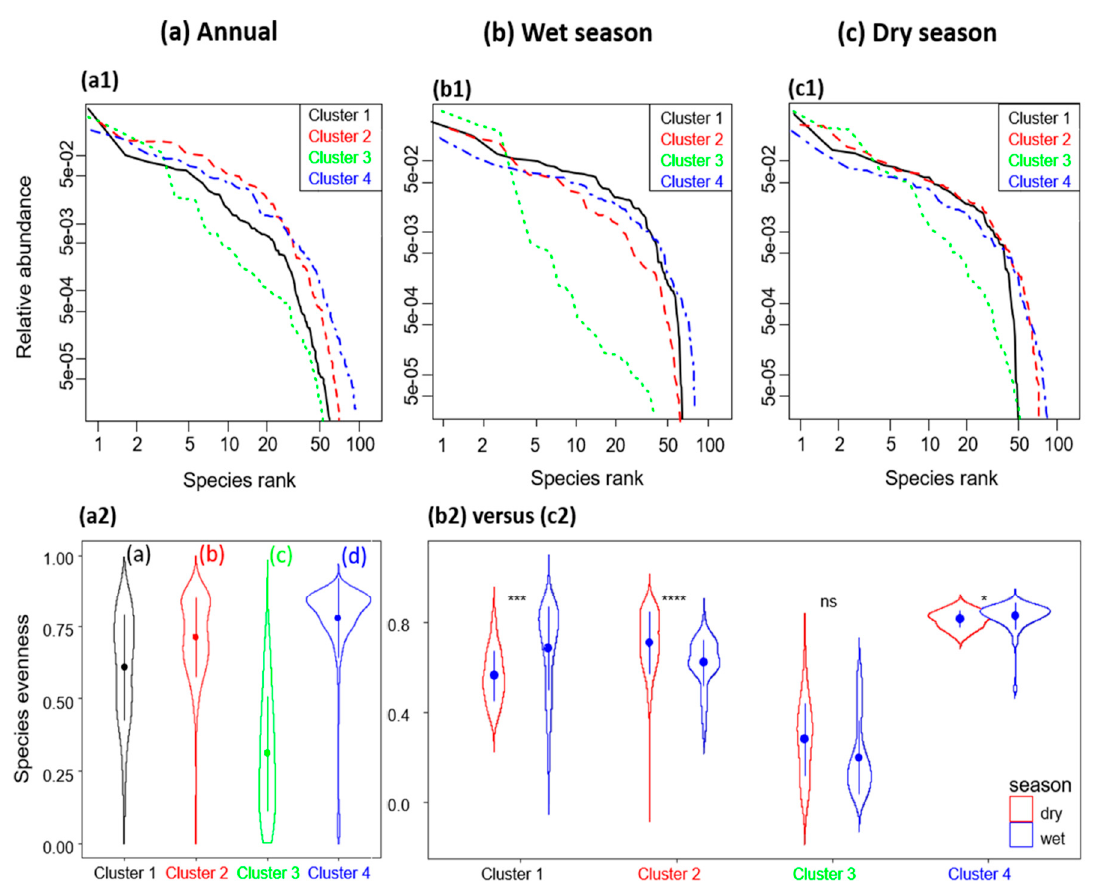
Figure 4. Rank-abundance plot by cluster: ( a ) annual, ( b ) wet season and ( c ) dry season. ( a1 , b1 , c1 ) are relative abundance curves (log-scale), ( a2 , b2 , c2 ) show species evenness indices. Clusters with a common letter are not significantly di ff erent at p = 0.05 (Pairwise Wilcoxon rank sum tests); sign (****) and (*) indicates significant di ff erences at p < 0.001 and p ≤ 0.05, (***) indicates significant di ff erence at p = 0.001, respectively between wet and dry seasons, and “ns” denotes “non-significance” (Kruskal–Wallis test).